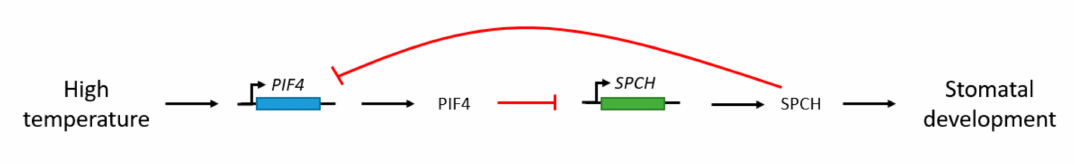
Figure 6. Model of the PIF4 and SPCH regulation of stomatal development when exposed to high temperatures. At high temperatures, the PIF4 gene is induced and PIF4 binds and represses the SPCH gene. The negative feedback loop of SPCH on the PIF4 promoter is